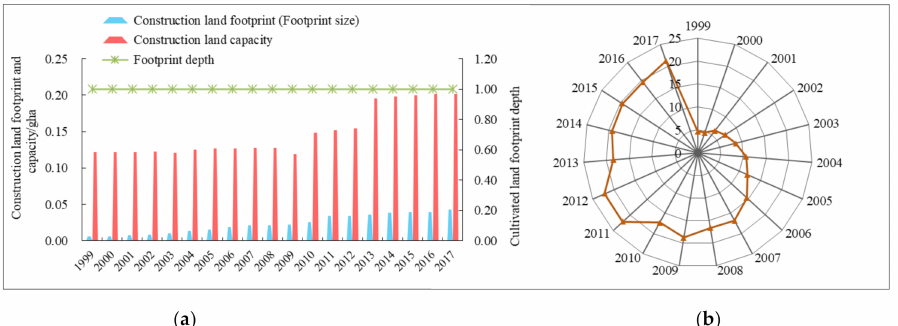
Figure 6. Changes in construction land’s natural capital use ( a ) and utilization efficiency of capital flows ( b ) in Ningxia.